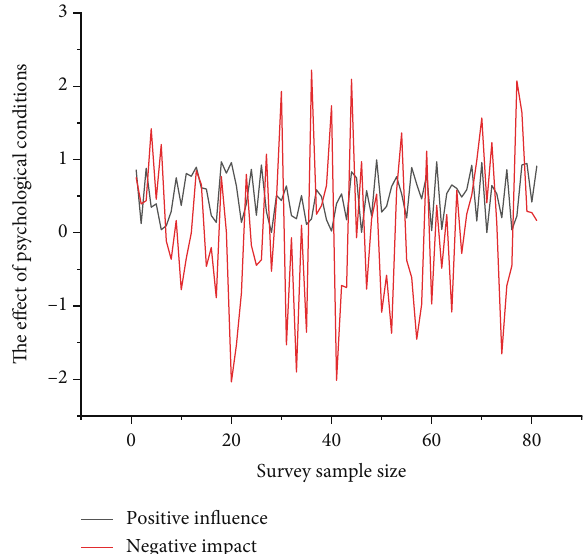
Figure 6: Impact of mobile social media sharing behavior on various aspects of mental